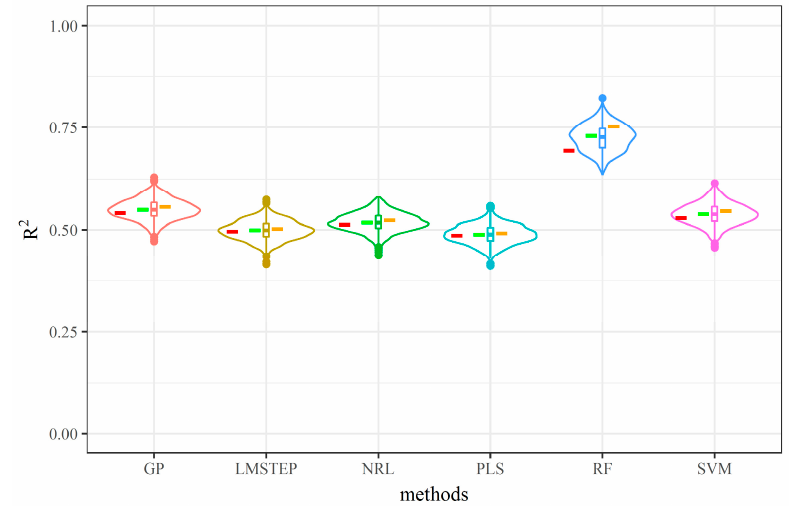
Figure 7. The distribution of R 2 values of the six prediction methods created with different cross-validation settings.